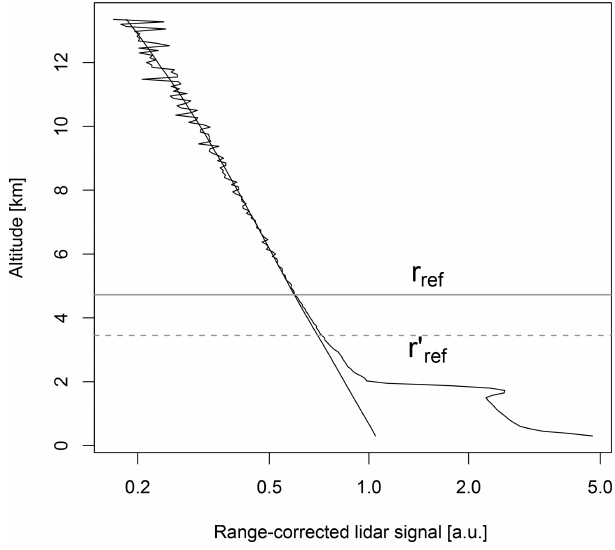
Figure 4. Reference altitude determination. r (cid:48) mation of the minimum altitude free of aerosols and clouds. r ref is the final value used in this